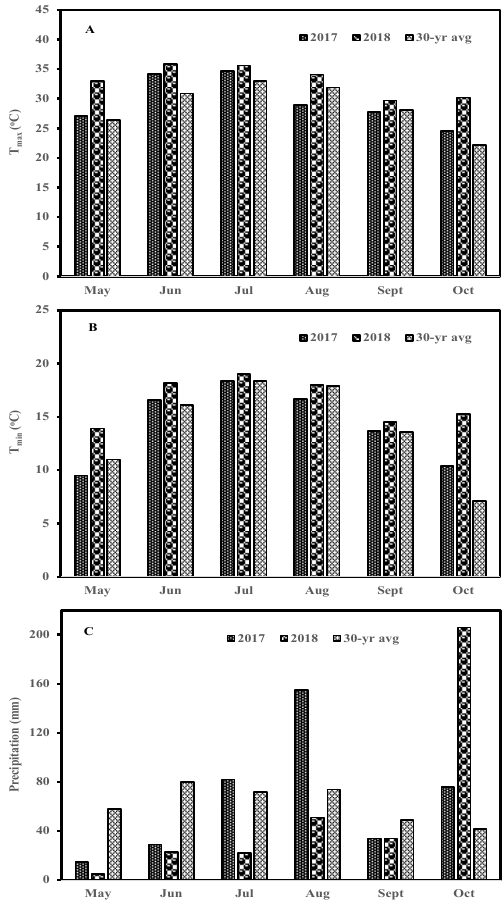
Figure 1. Mean monthly maximum temperature (T max, A ) and minimum temperature (T min, B ), and total precipitation ( C ) during sorghum growing season (May–October) and 30-year average (1981–2010) at Bushland, Texas (source: http//ncdc.noaa.gov, accessed on 15 August 2022).